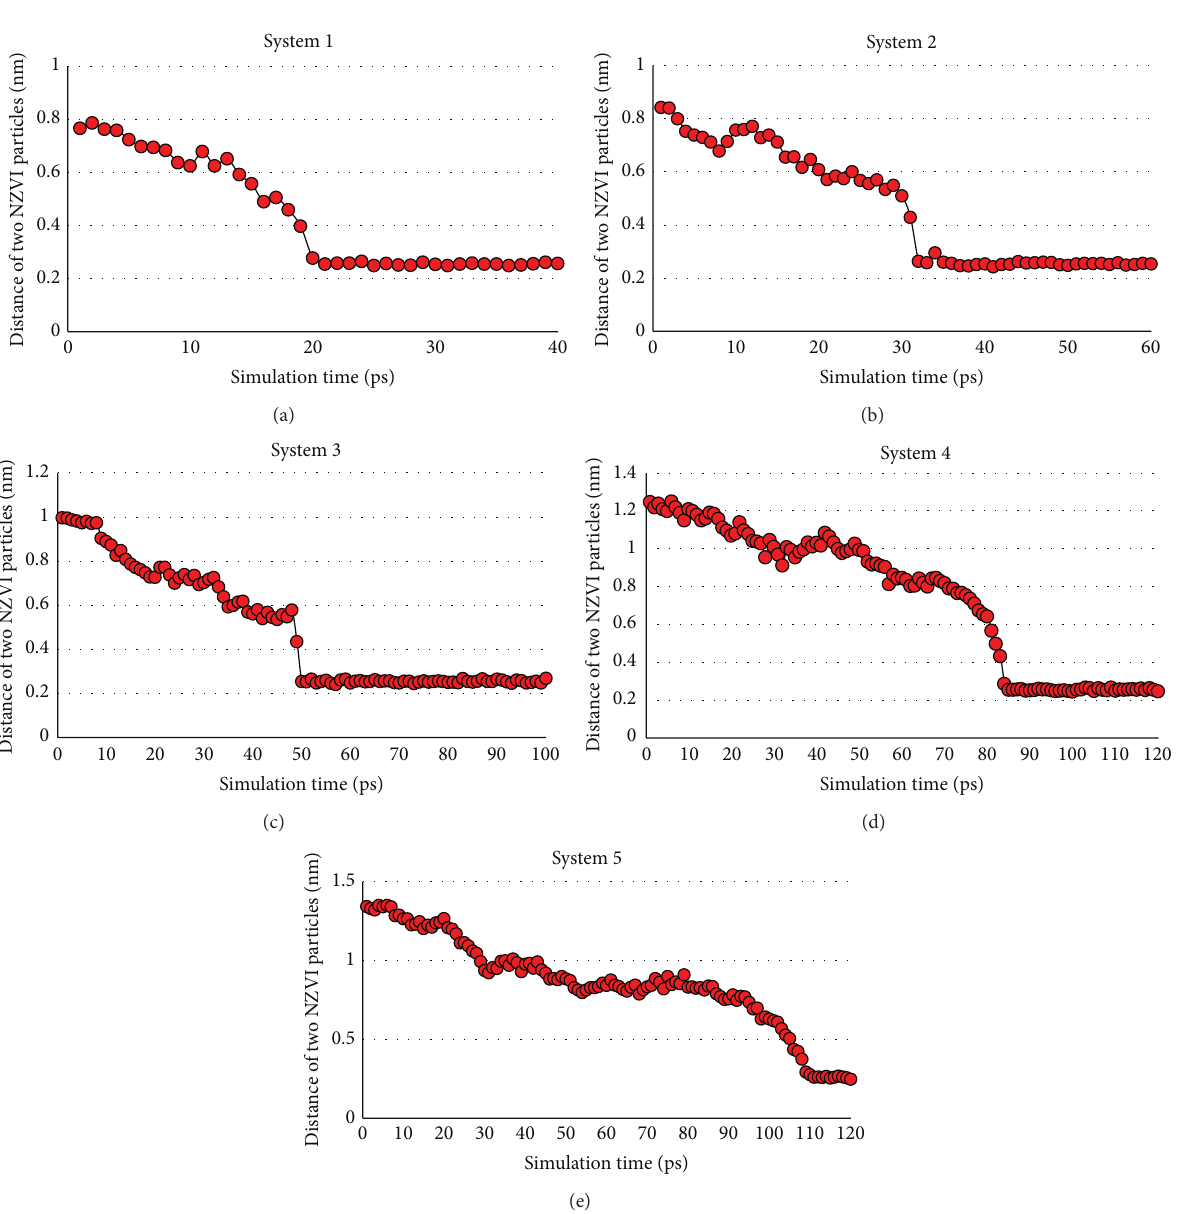
Figure 7: Distance change of two NZVI particles in whole simulation process of systems